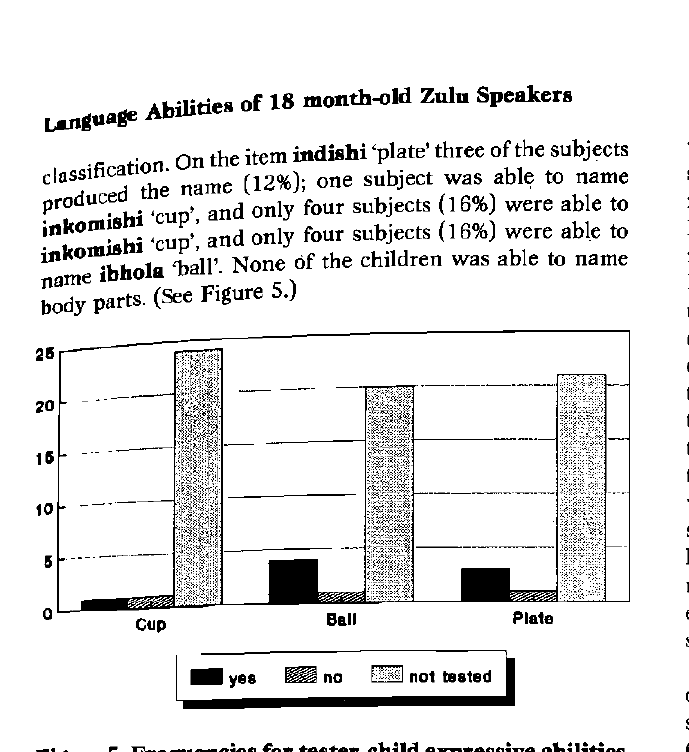
Figure 5: Frequencies for tester-child expressive abilities From these results, it can be seen that the tester-child as- sessment of expression yielded very few examples of childrens'